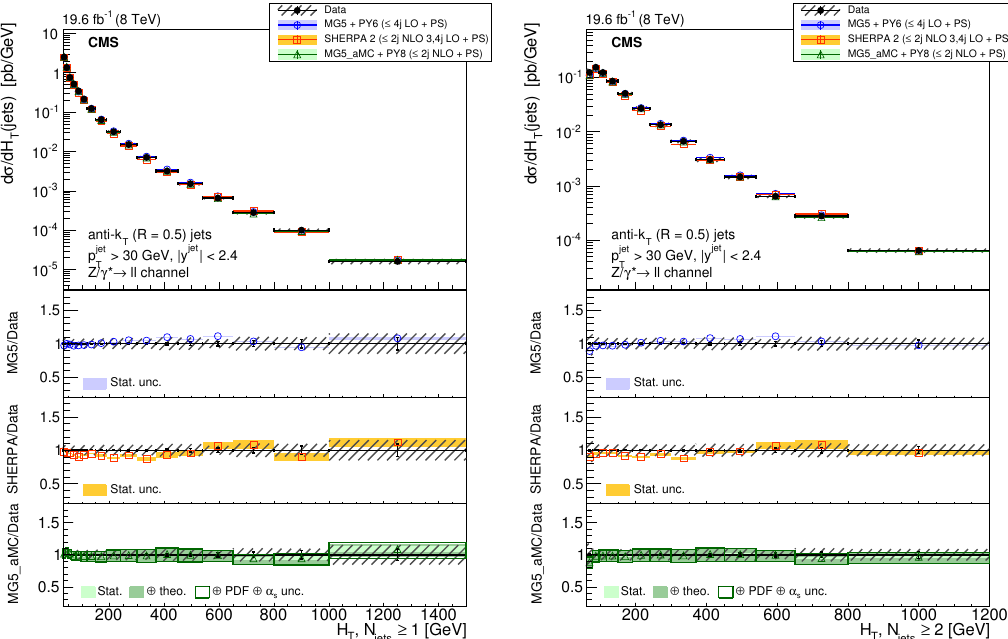
Figure 15 . The di(cid:11)erential cross section for Z ( ! ‘‘ ) + jets production measured as a function of H T for (left) N jets (cid:21) 1 and (right) N jets (cid:21) 2 compared to the predictions calculated with MadGraph 5 + pythia 6, sherpa 2, and mg5 a mc + pythia 8. The lower panels show the ratios of the theoretical predictions to the measurements. Error bars around the experimental points show the statistical uncertainty, while the cross-hatched bands indicate the statistical and systematic uncertainties added in quadrature. The boxes around the mg5 a mc + pythia 8 to measurement ratio represent the uncertainty on the prediction, including statistical, theoretical (from scale variations), and PDF uncertainties. The dark green area represents the statistical and theoretical uncertainties only, while the light green area represents the statistical uncertainty